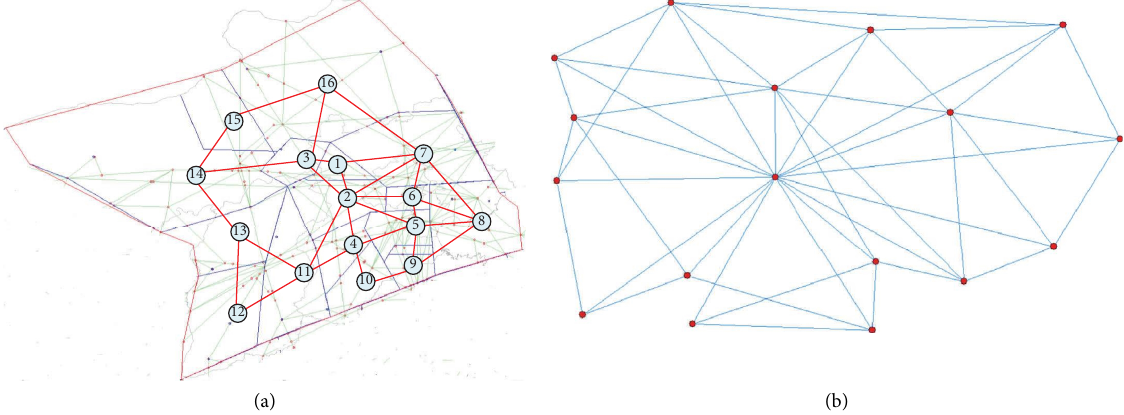
Figure 7: Te ASCN model of BCA. (a) Air sectors in the BCA. (b) Air sector network.